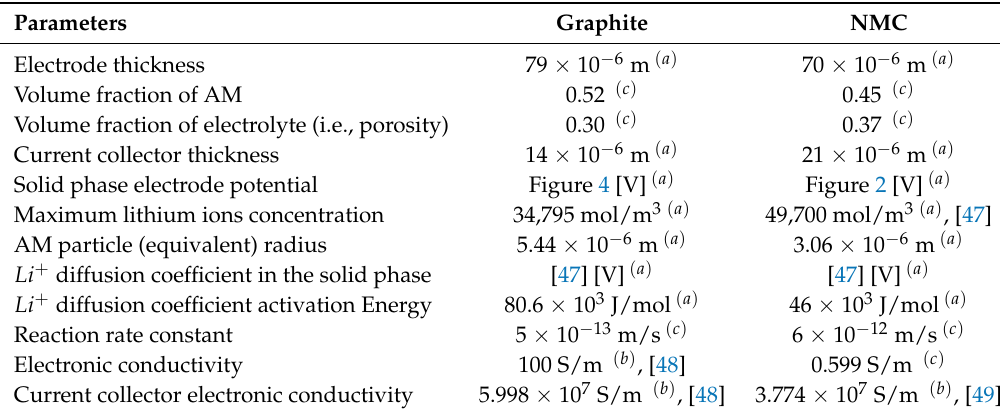
Table A2 lists the electrochemical parameters values associated to the cycled porous electrodes. Table A2. Electrochemical parameters values: cycled porous